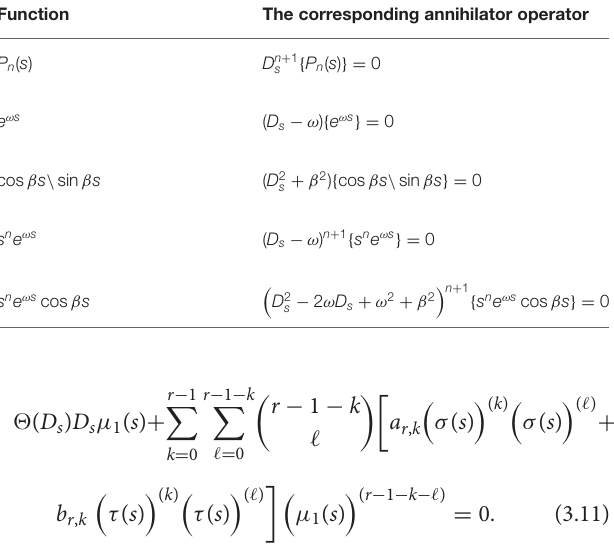
TABLE 1 | Annihilator operators of some functions.